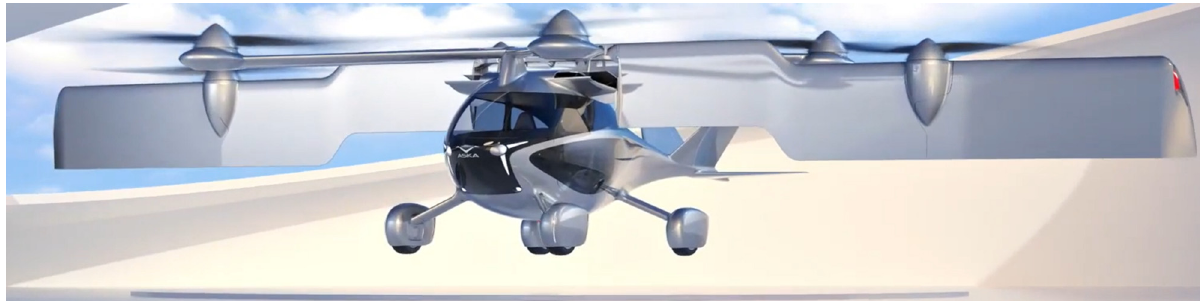
Figure 11: An imagined view of the ASKA ™ fl ying car during landing ( image credit: NFT Inc., used with permission ) .